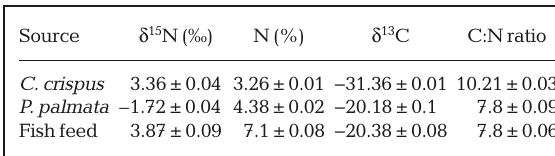
Table 1. Isotope composition of hatchery-reared macroalgae Chondrus crispus and Palmaria palmata prior to incubation in the field, and of the fish feed used at the salmon farm. Error is ± 1